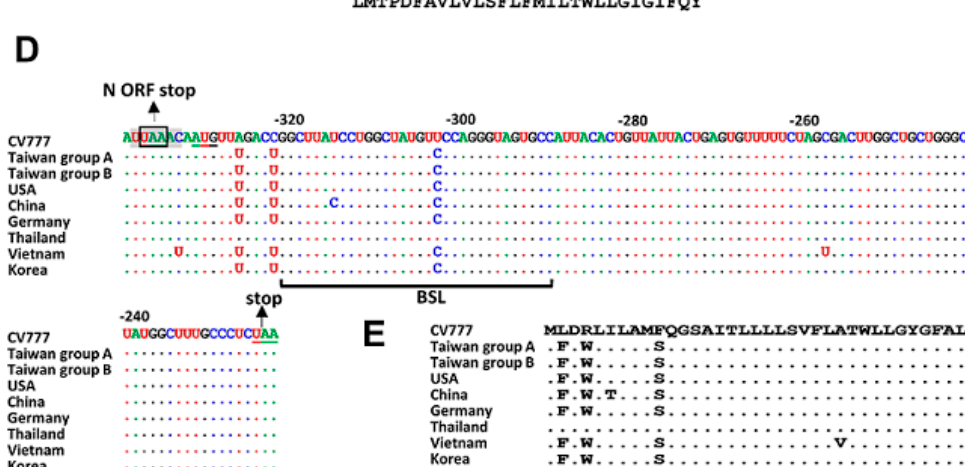
Figure 3. Identification of a novel subgenomic mRNA (sgmRNA) derived from the 3 ′ UTR of PEDV. ( A ) Identification of a sgmRNA derived from 3 ′ UTR. RT-PCR products of ≈ 1700 bp and ≈ 250 bp were observed from PEDV-infected Vero cells (lane 2), but not from mock-infected Vero cells (lane 3). Lanes 1 and 4, ds DNA size markers. ( B ) Upper panel: Nucleotide sequence of the newly identified sgmRNA ORF. The stop codon for the N ORF is boxed. CS-B is shaded in gray. The potential start codon and stop codon for the ORF are underlined. Lower panel: The deduced amino acid sequence of the ORF shown in upper panel. bp, base pair. ( C ) Left panel: Illustration of the relative position of the stop codon (for the N ORF), core sequence (for initiating the corresponding sgmRNA) and start codon of the ORF for PEDV, transmissible gastroenteritis coronavirus (TGEV), coronavirus 229E, and bat coronavirus 512. The stop codon for the N ORF is boxed. CS-B is shaded in gray. The start codon for the ORF is underlined. Right panel: Deduced amino acid sequence of the ORF for the aforementioned Alphacoronaviruses . ( D ) Alignment of the nucleotide sequence of the ORF between CV777, TW, and reference strains. CS-B is shaded in gray. The stop codon for the N ORF is boxed. The start and stop codons for the novel ORF is underlined. ( E ) Alignment of the deduced amino acid sequence of the novel ORF between CV777, TW, and reference strains. TGEV (GenBank accession number DQ811788.1); coronavirus 229E (GenBank accession number JX503061.1); Scotophilus bat coronavirus 512 (GenBank accession number NC_009657.1).